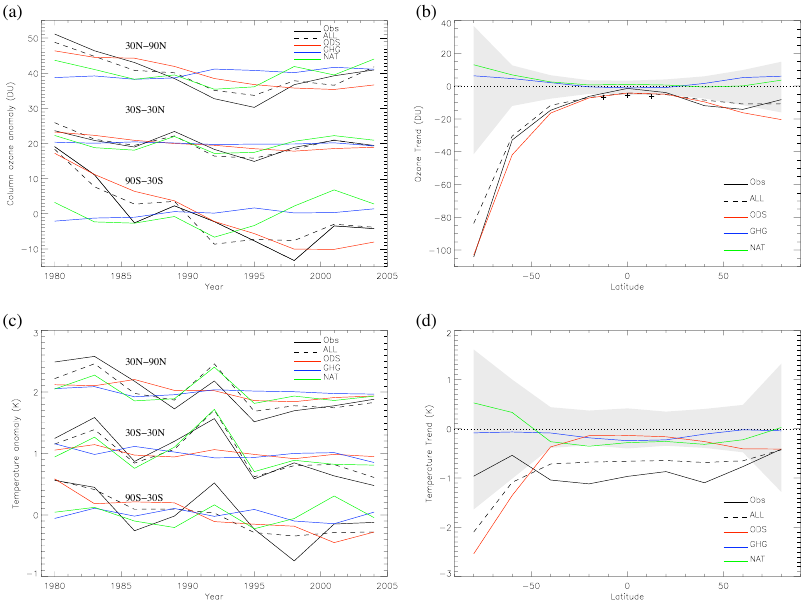
Fig. 1. Comparison of simulated and observed changes in total column ozone ( a and b ) and lower stratospheric temperature ( c and d ). Panel (a) shows 3-yr mean total column ozone anomalies from a merged TOMS/SBUV dataset and simulated in response to ODS, GHG, NAT and all forcings combined over three zonal bands in DU. Anomalies for 30 ◦ S–30 ◦ N and 30 ◦ N–90 ◦ N are offset by 20DU and 40DU respectively. Zonal mean least-squares linear trends in total column ozone in observations and simulated in response to each forcing are shown in (b) in DU over the 27-period 1979–2005. Grey bands show the estimated 5th–95th percentile ranges of internal variability. Black crosses in (b) show stratospheric column ozone trends estimated from TOMS data using the convective cloud differential method (Ziemke et al., 1998). (c) and (d) are equivalent plots for MSU lower stratospheric temperature, in K over the 27-yr period 1979–2005. Anomalies for 30 ◦ S–30 ◦ N and 30 ◦ N–90 ◦ N are offset by 1K and 2K respectively in (c)